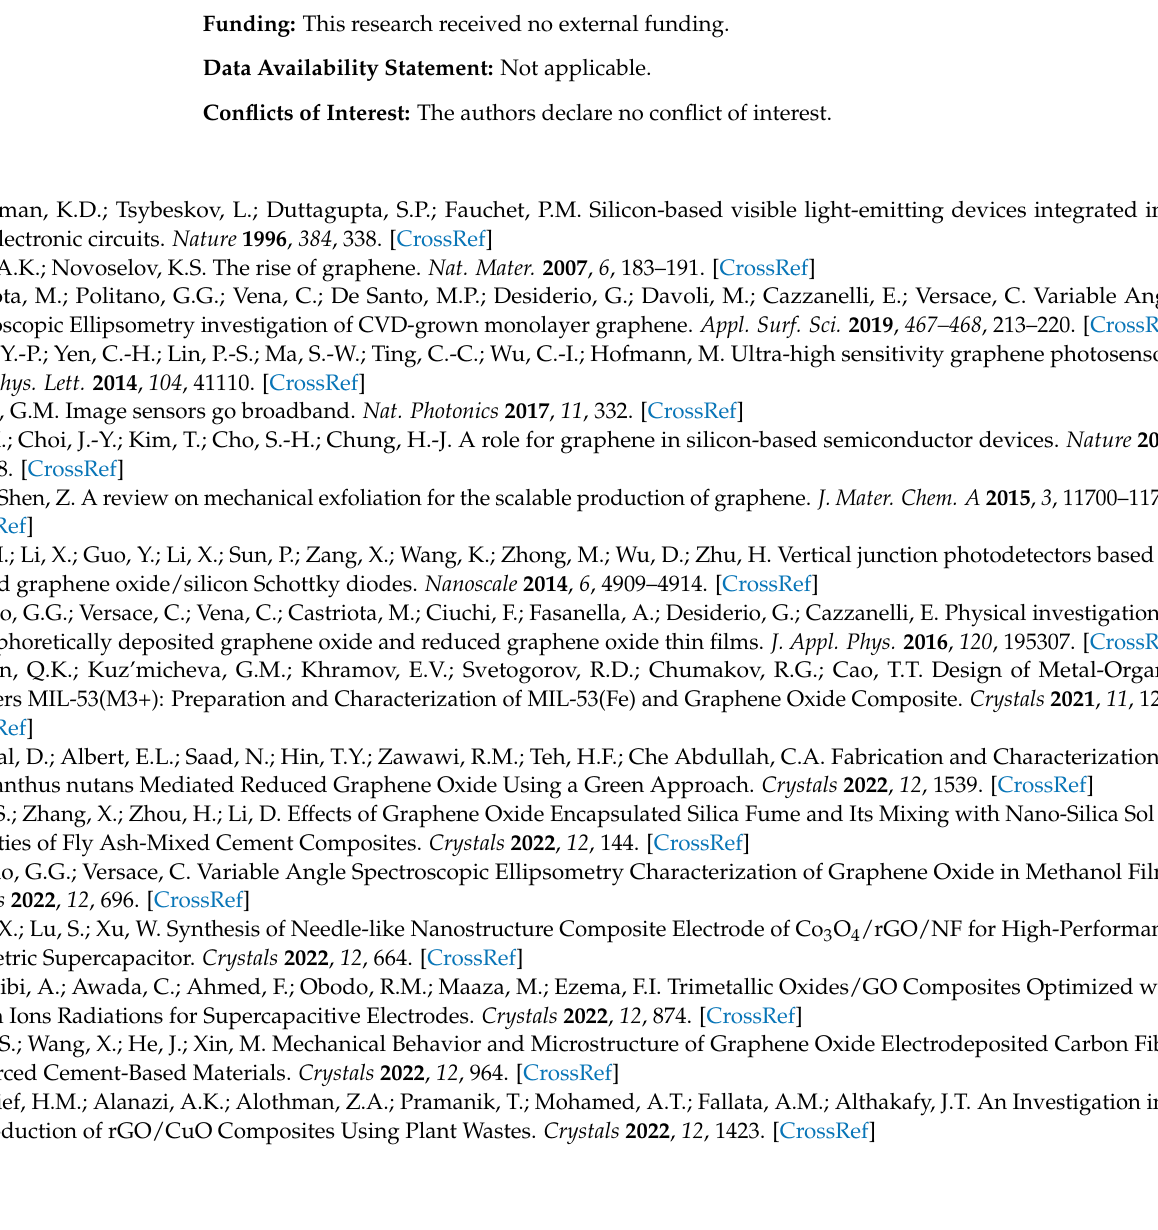
on Si substrates (p-type). Figure S3: Particle size distribution of very diluted GO flakes in water. Figure S4: Variable angle spectroscopic ellipsometry measurements of graphene oxide films on Si substrates (n-type). Experimental and model generated ψ (a) and ∆ (b) data fit at different angles of incidence. Figure S5: Variable angle spectroscopic ellipsometry measurements of graphene oxide films on Si substrates (p-type). Experimental and model generated ψ (a) and ∆ (b) data fit at different angles of incidence. Figure S6: Impedance measurements on n-type Si and graphene oxide/n-type Si samples under dark and light illumination conditions. Figure S7: Cyclic voltammetry measurements on n-type Si and graphene oxide/n-type Si samples under dark and light illumination